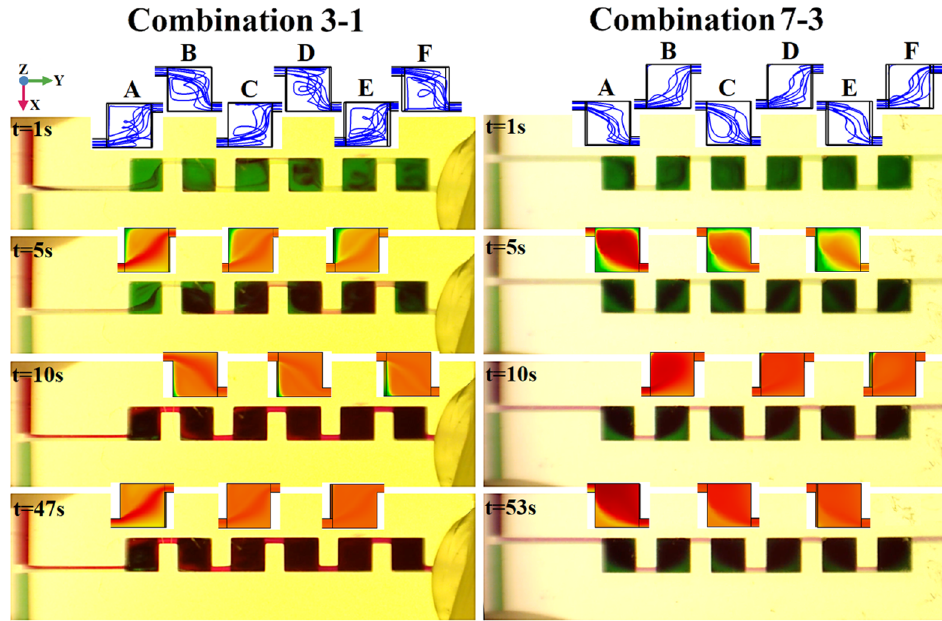
Figure 10. Microscopic images of mixers with different junction location combinations at different times.